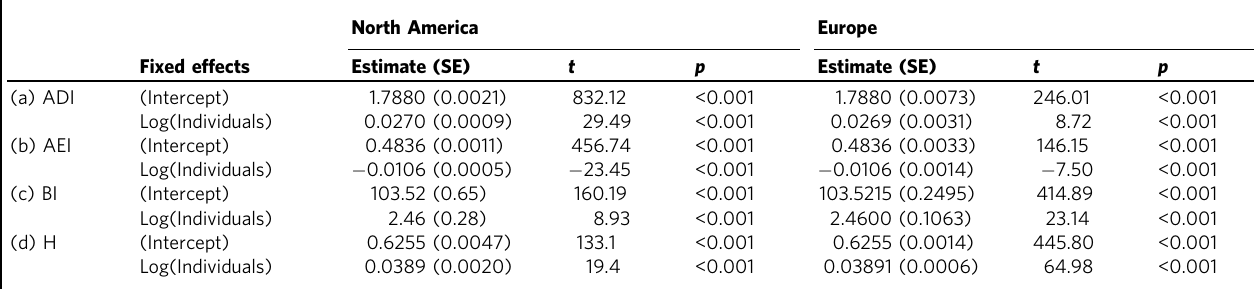
Table 1 Results of GLMs of the association between the acoustic properties of reconstructed soundscapes and the number of individuals (1 – 10) of a single species present in a simulated community and contributing to that soundscape.